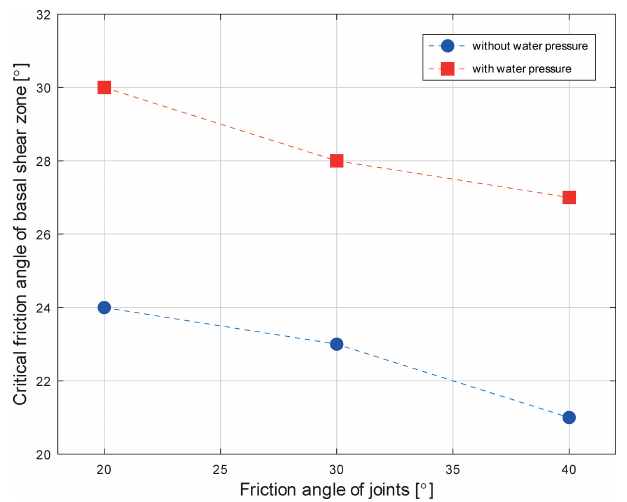
Figure 11. Relationship between the applied friction angle of the joints in the rockslide mass and the back-calculated critical friction angle of the basal shear zone at failure, grouped into model runs without and with groundwater flow (cohesion was set to zero for joints and the basal shear zone).